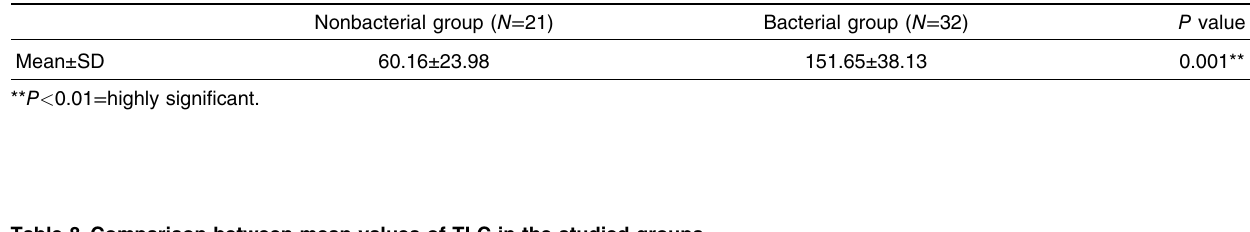
Table 7 Comparison between mean values of serum procalcitonin in the bacterial and nonbacterial groups